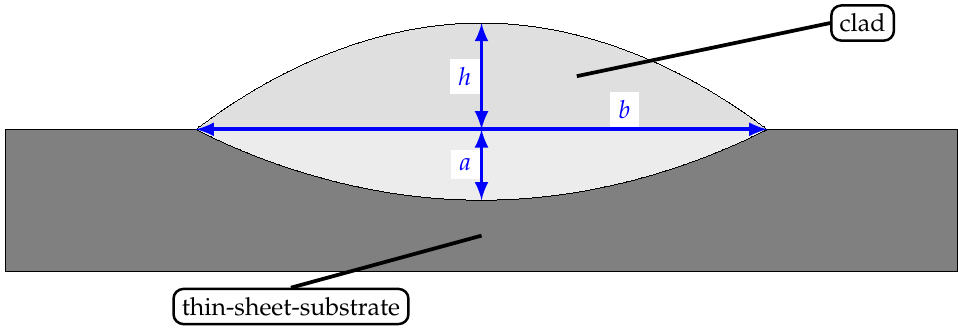
Figure 2. Schematic representation of target values’ clad width b , clad height h , and dilution depth a during high-speed laser cladding of thin-sheet